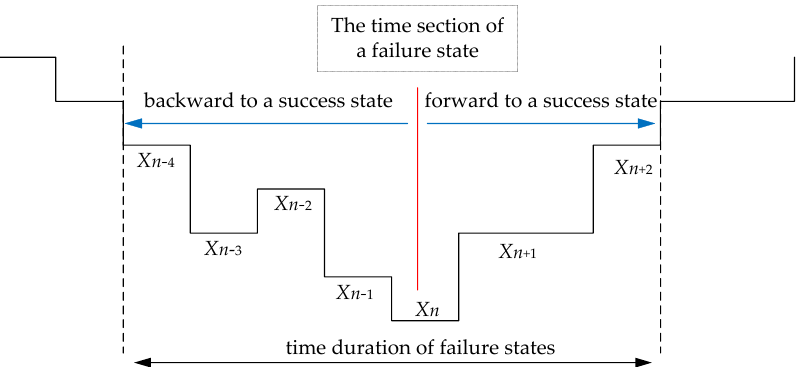
Figure 2. The schematic diagram of forward and backward method used in pseudo-sequential Monte Carlo simulation (PMCS).